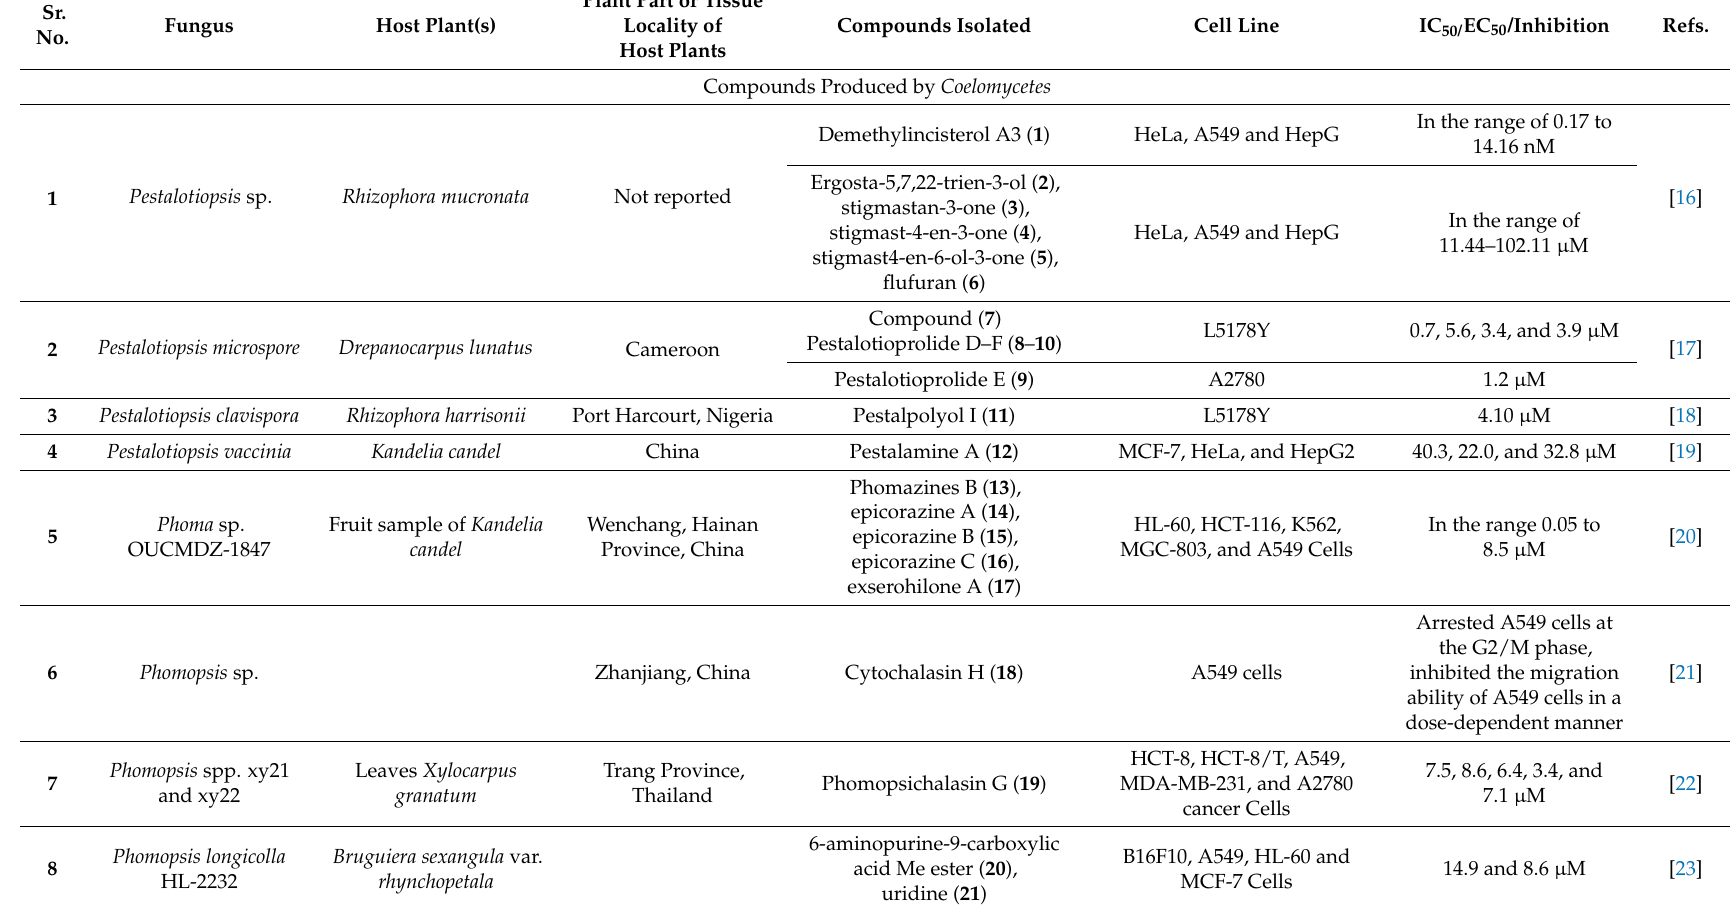
Table 1. Novel anticancer bioactive compounds reported from mangrove